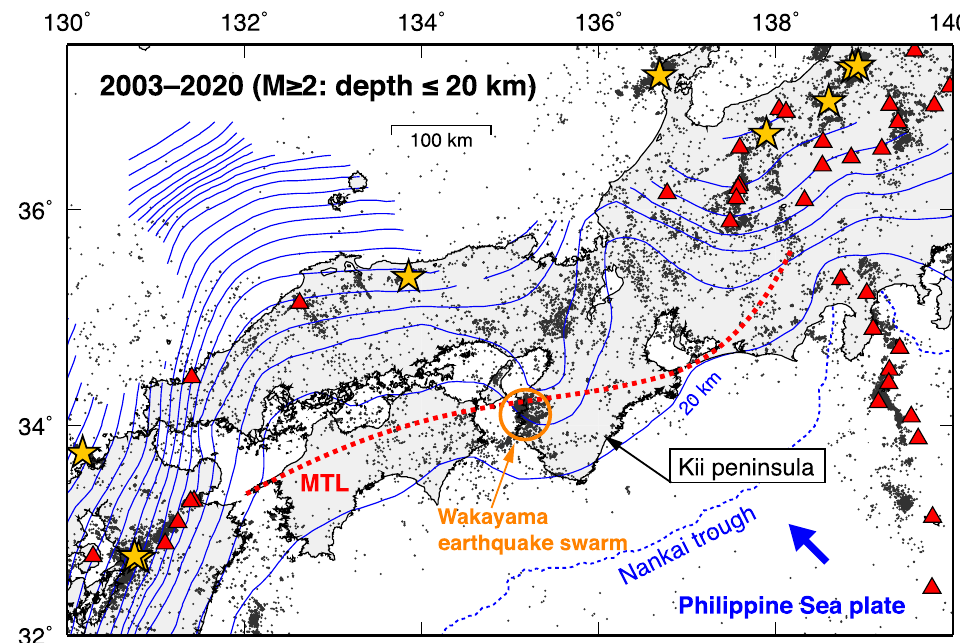
Fig. 1 Tectonic framework of western Japan. Blue solid denote the iso-depth contours of the Philippine Sea (PHS) slab at a 20-km interval (Hua et al. 2018, and references therein). Red triangles and orange stars represent active volcanoes and M the 2003–2020 period, respectively. Dots indicate the M divides southwestern Japan into the inner and outer arcs, is shown by the dashed red line. Blue dashed lines denote the location of the Nankai